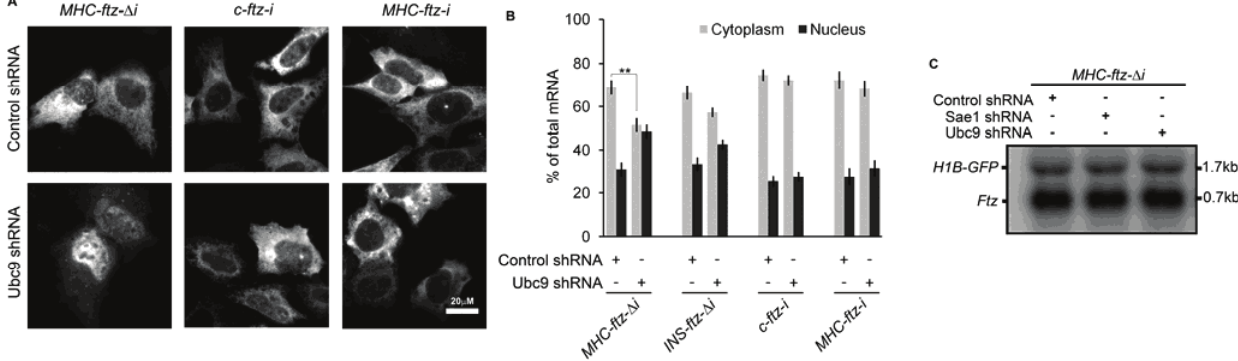
Figure 3. Ubc9-depletion has no effect on the export of spliced ftz mRNA and does